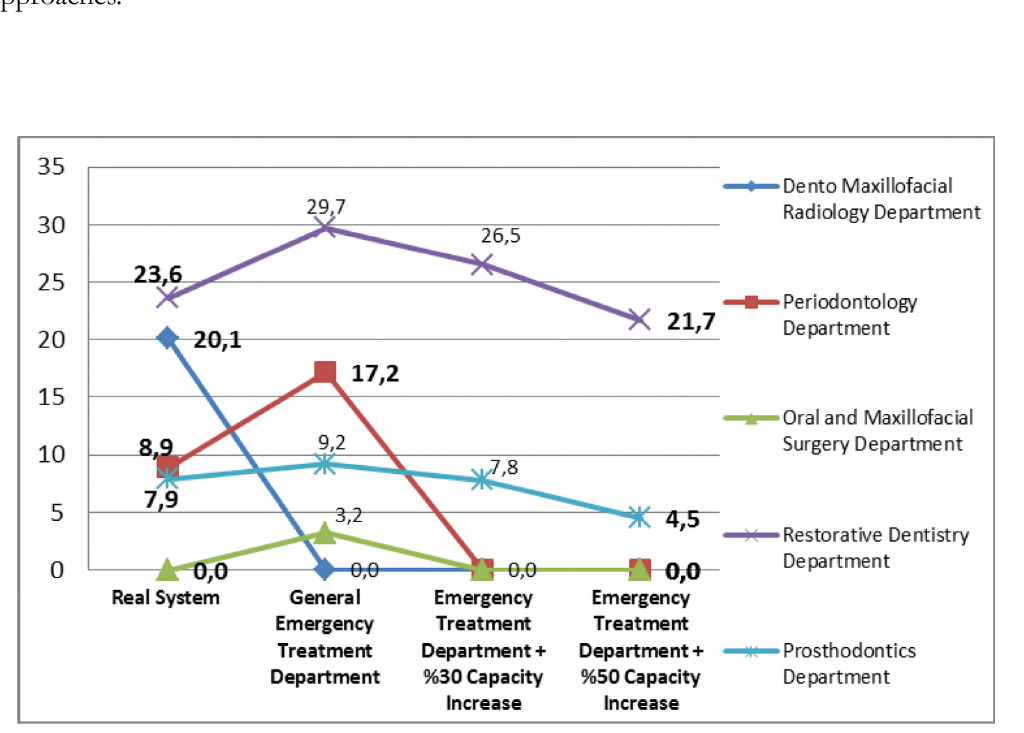
Figure 10. The rate of patient relinquishment for alternative approaches (%)